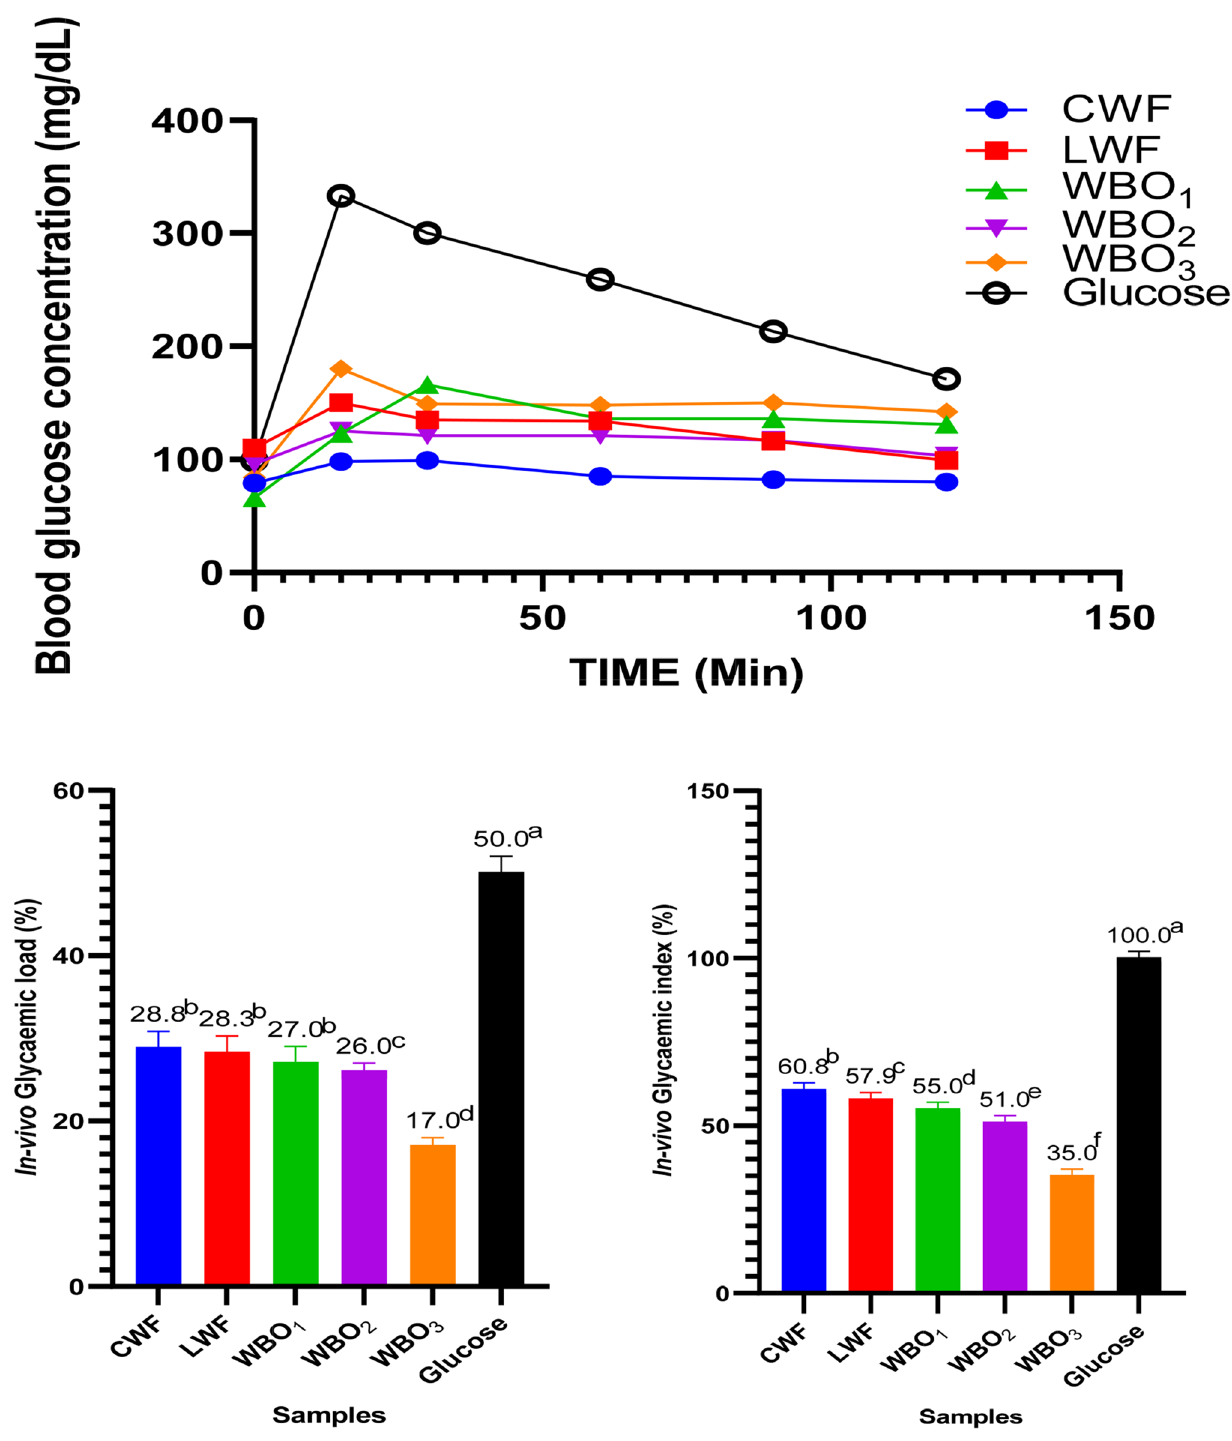
75% bambara groundnut (WBO and Laboratory wheat flour ); 1 ); 25% wheat, and 2